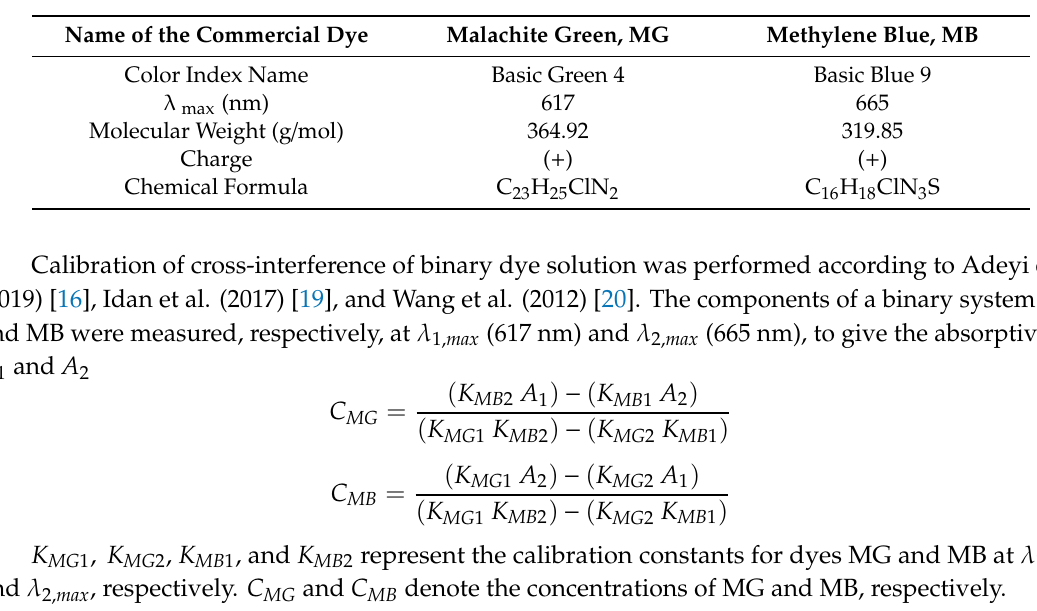
Table 1. General properties of cationic MG and MB